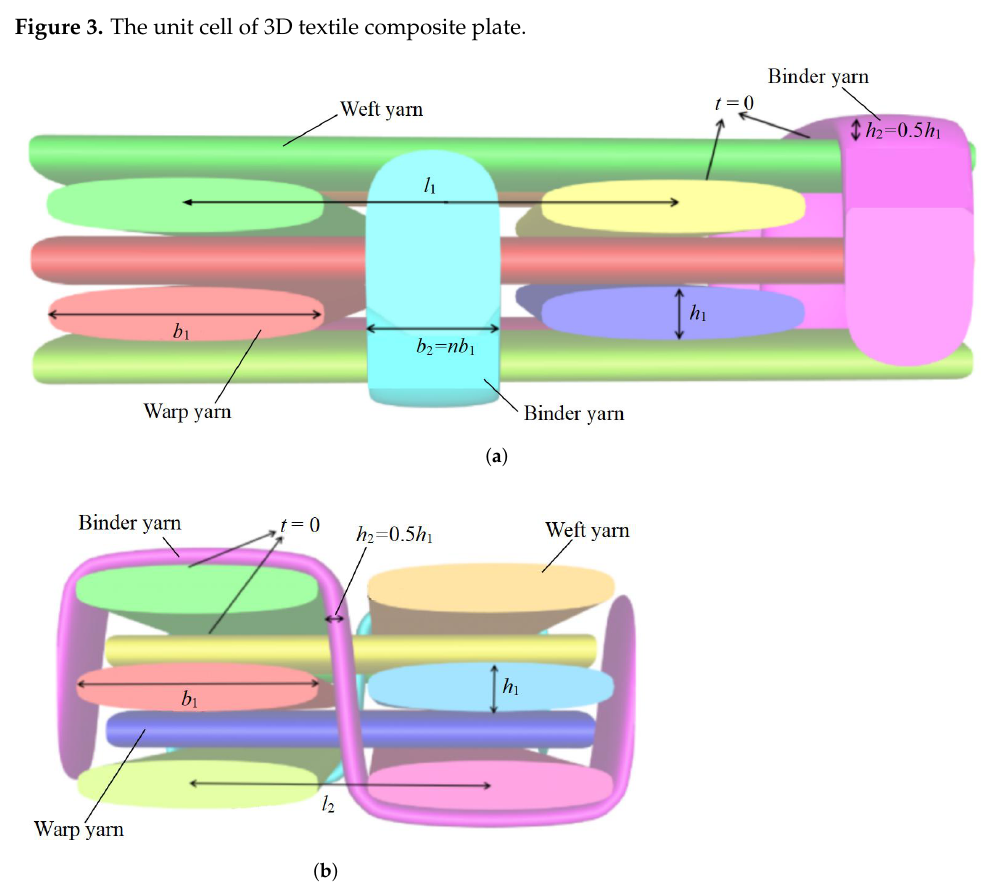
Figure 4. Structural parameters of unit cell within the 3D-TCP. ( a ) Y direction; ( b ) X